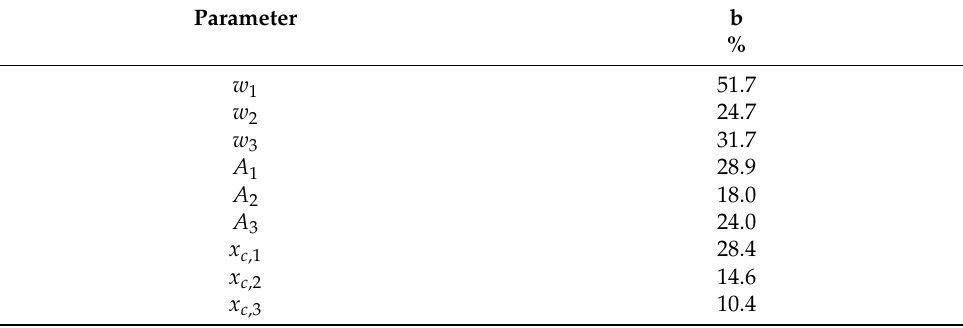
Table 4. Coefficient of variance of regression parameter b for w i , A i and x c , i